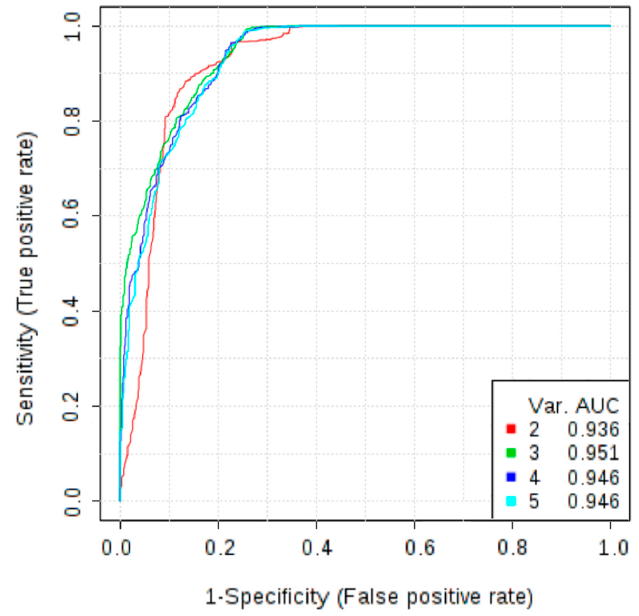
Figure 2. Multivariate receiver operating characteristic (ROC) curves representing correlations between concentrations of CA125, HE4, osteopontin, follistatin, PDGF-AB/BB in differentiating non- malignant ovarian tumours vs. ovarian cancer; Models 2 and 3 are mostly based on CA125, HE4 and osteopontin; Model 2 allowed to obtain an AUC of 0.936, while the model 3 , in which osteopontin is more frequently selected, increased the AUC to 0.951; The use of additional angiogenesis markers (models 4 and 5 ) did not improve the diagnostic